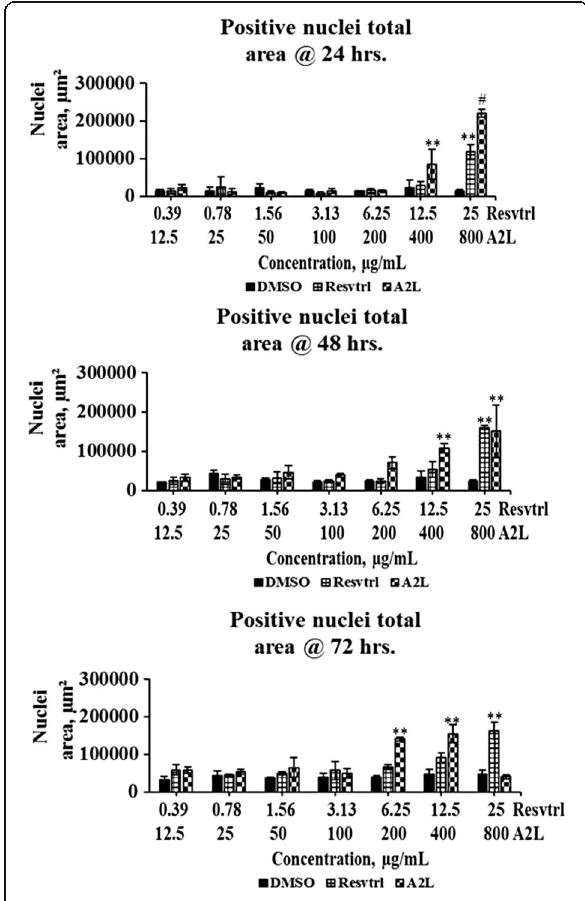
Fig. 5 Determination of positive nuclei total area. Changes in positive nuclear size associated with treatment of HepG2 cells with resveratrol or A2L followed up for three days